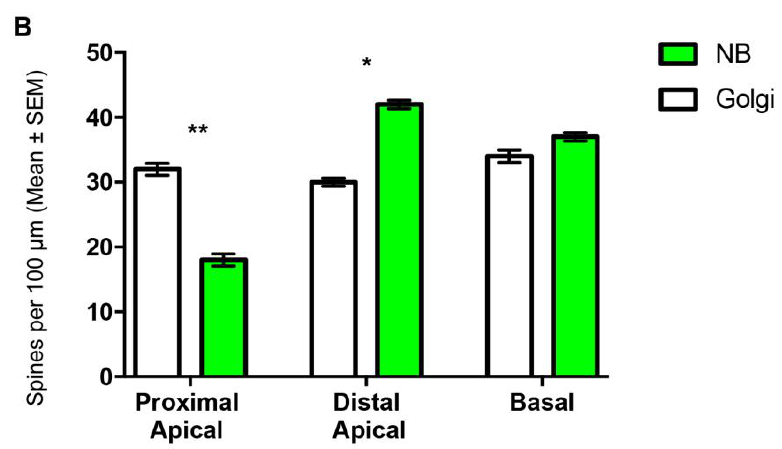
Figure 2. BLA principal neuron dendritic spine density from Golgi–Cox and NB-filled methods. ( A ) The top row shows representative Golgi–Cox, and the bottom row depicts representative NB-filled BLA principal neuron dendritic segments and dendritic spines (red arrowheads) from proximal apical, distal apical and basal dendrites; ( B ) shows a histogram comparing proximal apical, distal apical and total basal dendritic spine densities in Golgi–Cox-stained (open bars) and NB-filled (green bars) BLA principal cells. Unpaired Student’s two tailed t -tests, * p < 0.05, ** p < 0.01. Scale Bar: ( B ), 5 µ m.